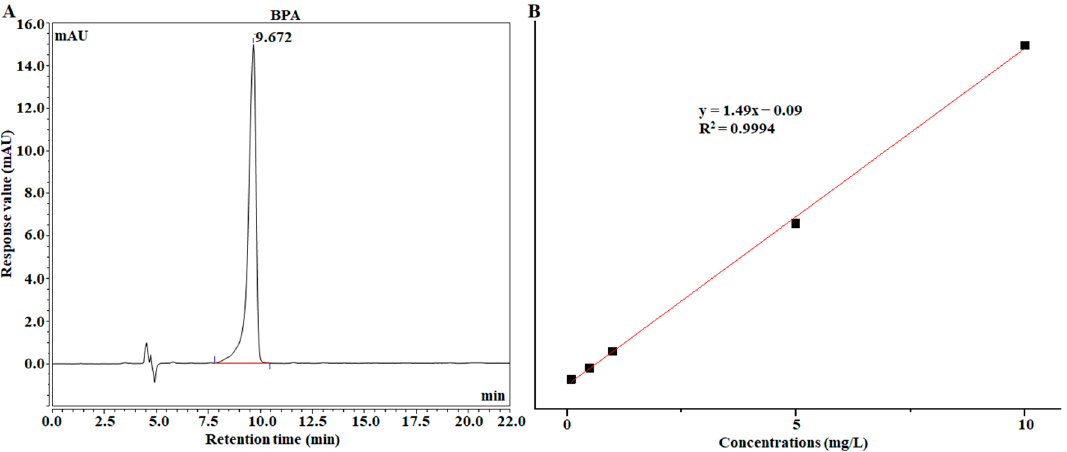
Figure 8. ( A ) HPLC detection results of BPA; ( B ) Standard curve between peak area and concentration in the range of 0.1–10 mg / L. Table 3. The recovery rate of BPA spiked with different addition levels and methods.